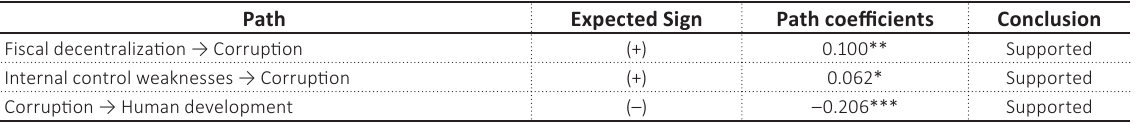
Table 4. Path coefficients and p-values results